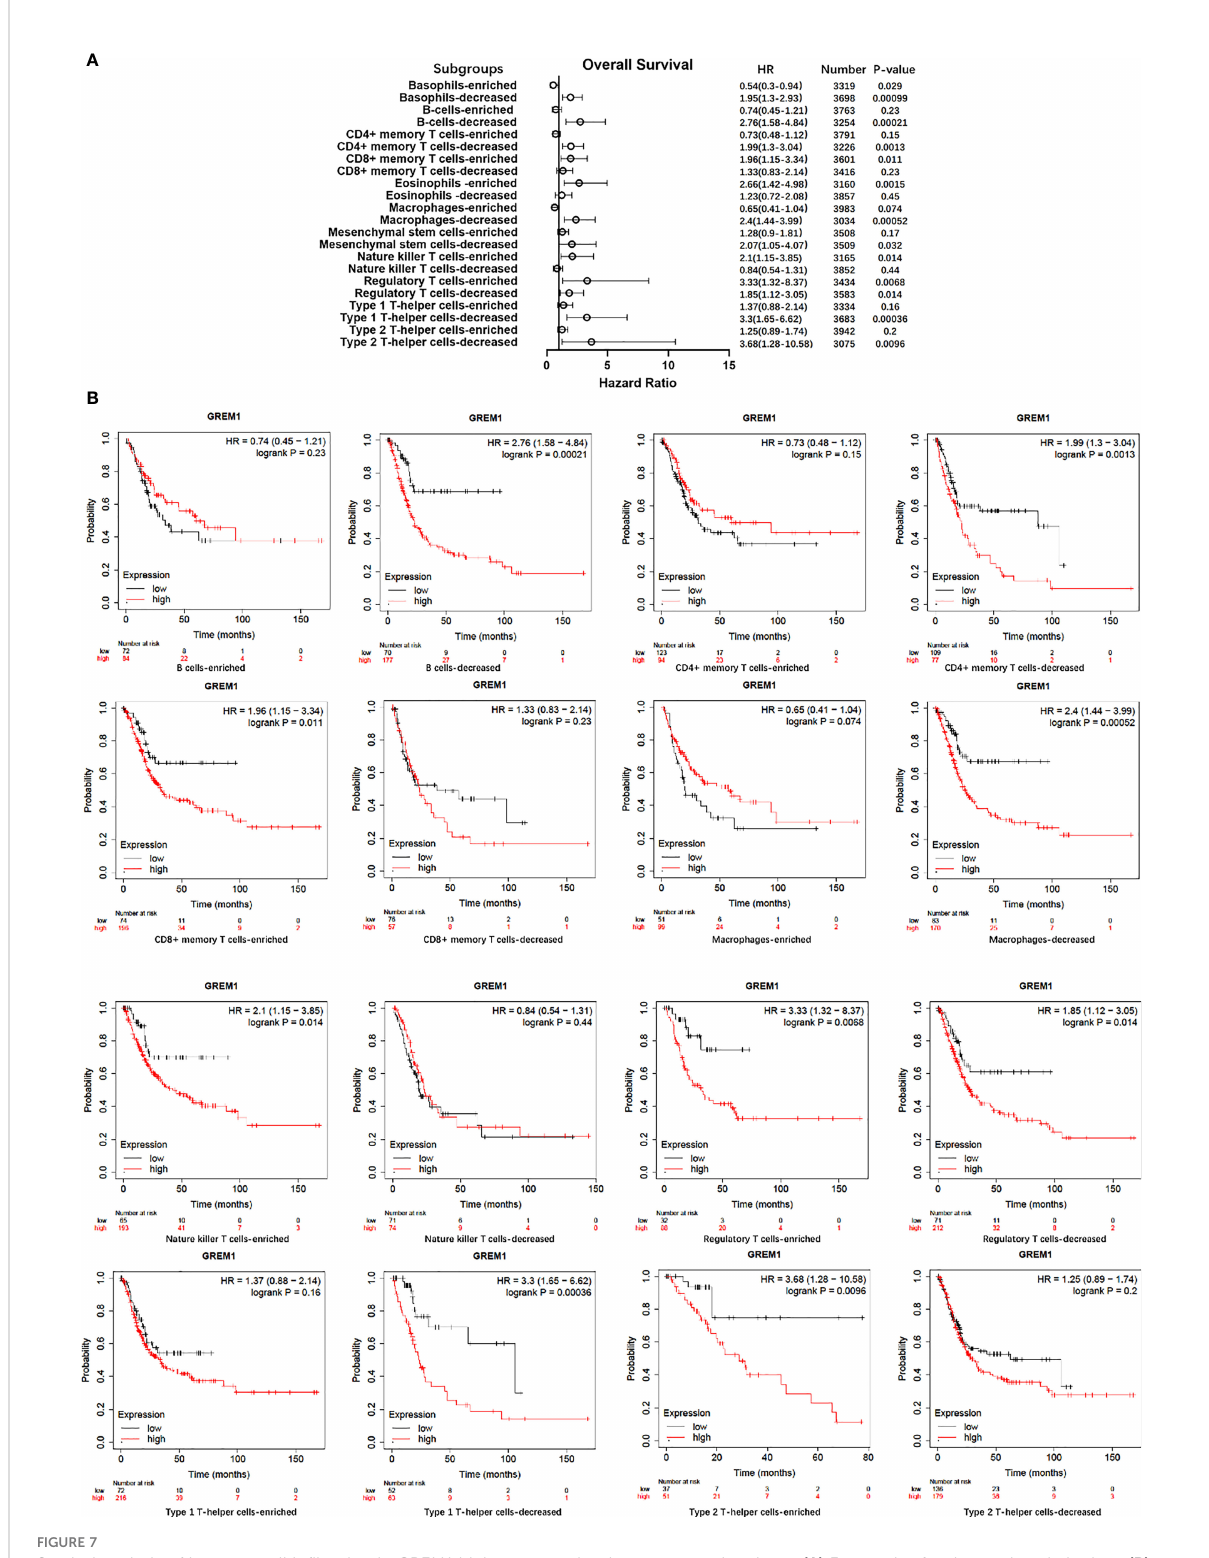
FIGURE 7 Survival analysis of immune cell in fi ltration in GREM1 high-expressed or low-expressed patients. (A) Forest plot for the total analytic data. (B) Survival analysis concerning GREM1 expression and immune cell in fi